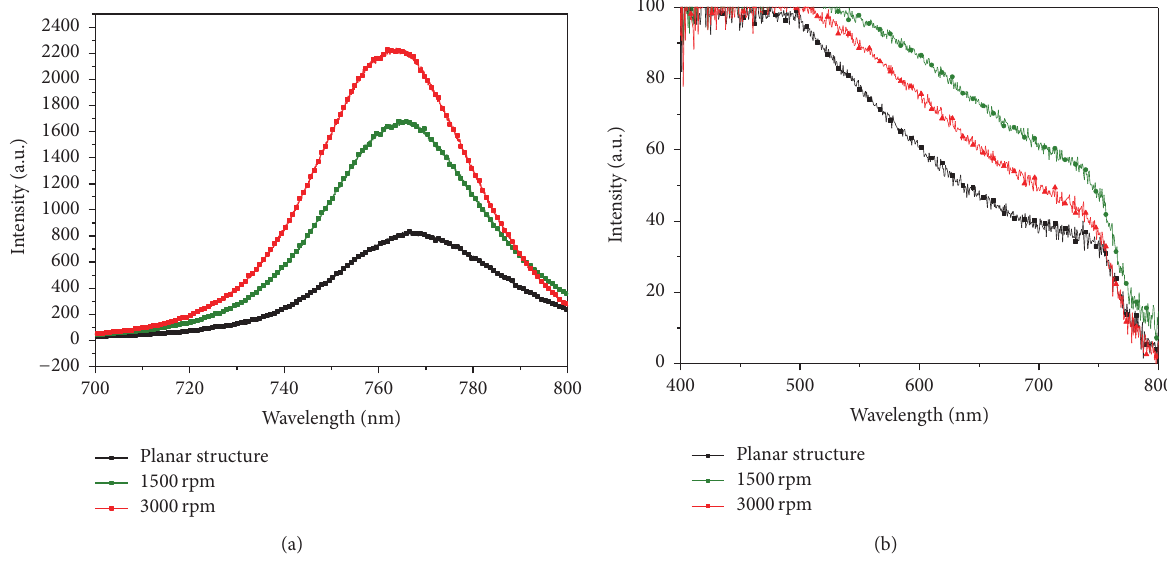
Figure 10: (a) PL diagram and (b) UV-Vis absorption spectrum of the CH 3 NH 3 PbI 3 perovskite thin films with planar structure and the spin-coating rates of the mp-TiO 2 precursor for 1500rpm and 3000